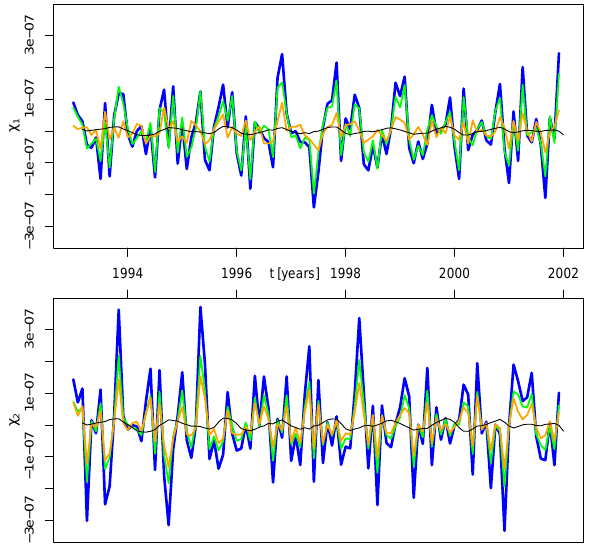
Fig. 2. Ocean angular momentum of the assimilation-simulation. Total ocean angular momentum (blue). Relative-term (orange). Mass-term (green). Part of the mass-term which is due to total ocean mass change (black).